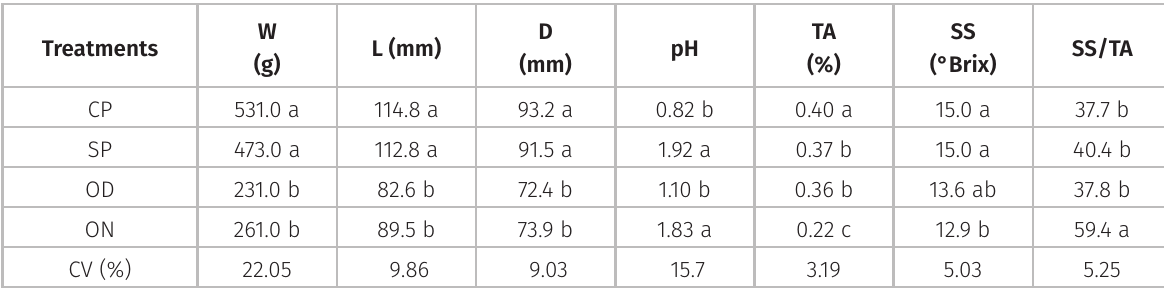
Table III. Fruit weight (W), length (L), diameter (D), pH, titratable acidity (TA), soluble solids (SS), and SS/TA ratio. Pollinations performed on 12/06/19. Treatments: cross-pollination (CP), self-pollination (SP), diurnal open pollination (OD), and nocturnal open pollination (ON).